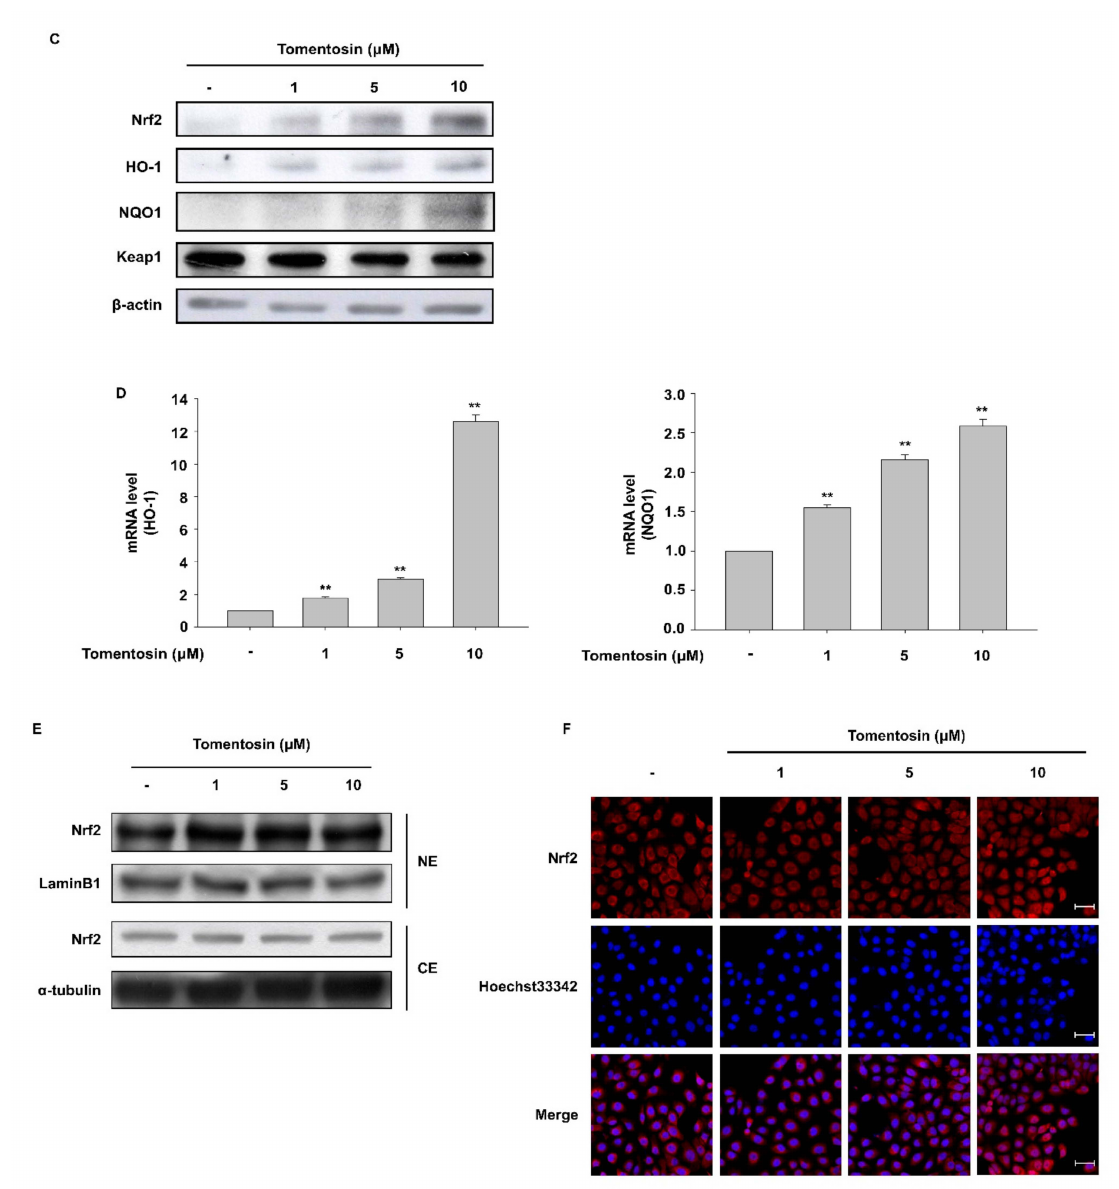
Figure 2. Tomentosin exerts antioxidant activity through activation of the nuclear factor erythroid 2-related factor 2 (Nrf2) signaling pathway. ( A ) 2,2-diphenyl-1-picrylhydrazyl (DPPH) radical scav- enging activity of tomentosin. DPPH (0.15 mM) was allowed to react with tomentosin and vitamin C. The data are shown as the mean ± SD of triplicates. ( B ) HaCaT cells were transfected with an antioxidant response element- (ARE-) luciferase reporter and incubated for 4 h. The cells were then incubated with the indicated concentrations of tomentosin for 24 h and subjected to a luciferase reporter assay. The data are presented as the mean ± SD of triplicates. TBHQ was introduced as a positive control. TBHQ, tert-Butyl hydroquinone. ( C – F ) HaCaT cells were incubated with 1, 5, or 10 µ M tomentosin for 24 h. ( C ) Protein levels of NAD(P)H-quinone oxidoreductase 1 (NQO1), Nrf2, Kelch-like ECH-associated protein 1 (Keap1), and heme oxygenase-1 (HO-1) were analyzed by Western blot. β -actin was introduced as the control for whole-cell lysates. ( D ) mRNA levels of HO-1 and NQO1 were analyzed by qRT-PCR. Glyceraldehyde 3-phosphate dehydrogenase (GAPDH) was used as the control. The results are shown as the mean ± SD of triplicates. ** p < 0.01 vs. untreated group. ( E , F ) Cells were analyzed by Western blotting ( E ) of nuclear and cytoplasmic fractions and by immunocytochemistry ( F ) to assess the level of Nrf2 nuclear translocation. α -tubulin and lamin B1 were introduced as the controls for cytoplasmic and nuclear protein extracts, respectively. NE, nuclear extracts; CE, cytosolic extracts. Scale bar = 50 µ